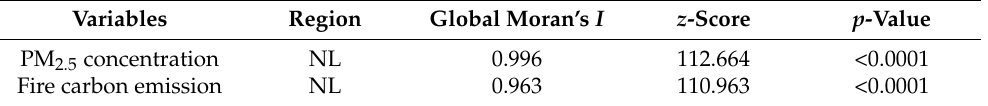
Table 1. Global Moran’s I of PM 2.5 concentration and fire carbon emission in the study area.